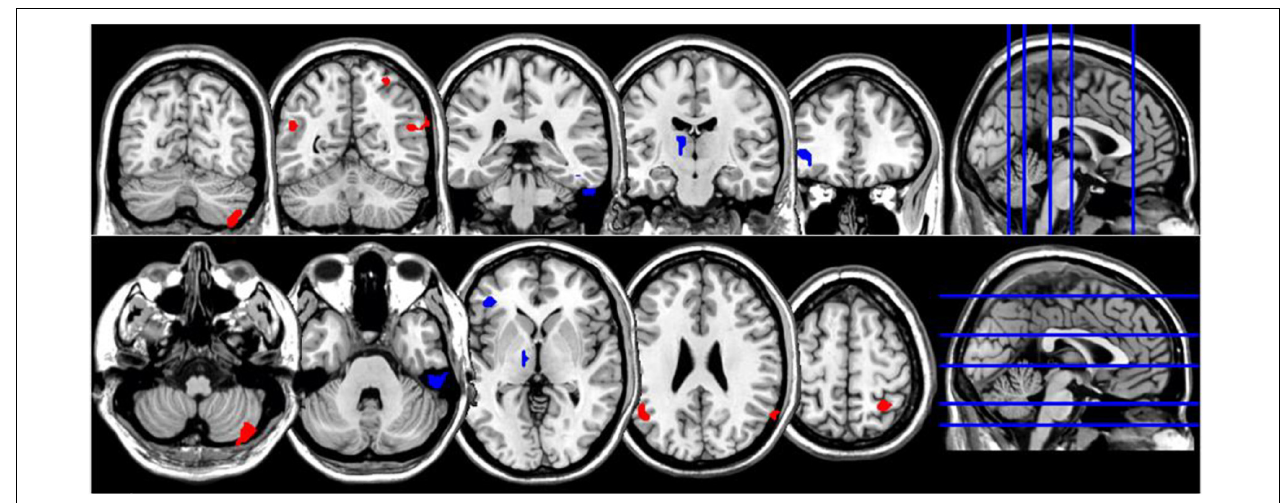
FIGURE 3 | Coronal and axial multislice views of regions showing correlations between NDQ scores and ReHo values in CTL group. Color code; red, regions for which the NDQ scores were associated with increased ReHo values; blue, regions for which the NDQ scores were associated with decreased ReHo values. Significant regions were obtained with the following combination of statistical thresholds: p < 0.01 at voxel level within clusters > 26. TABLE 5 | Localization of regions showing correlations between retrospective disturbed dreaming frequency estimates and ReHo values in the NM group. Cluster size